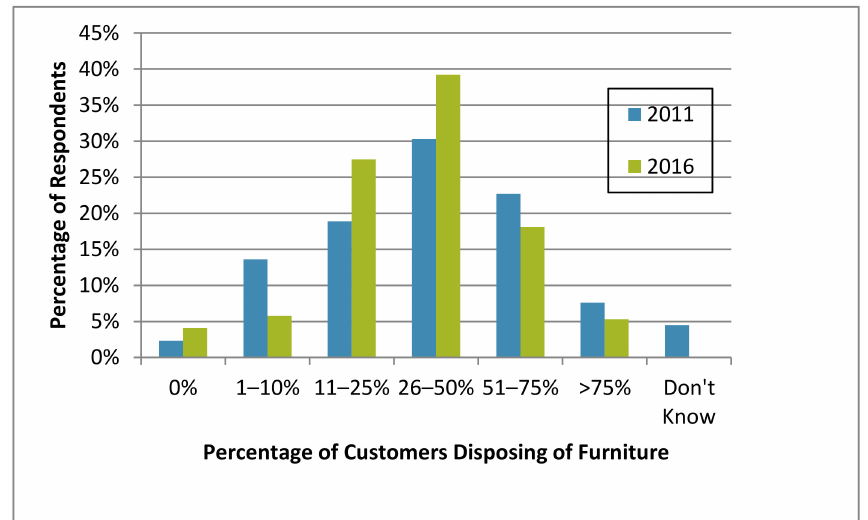
Figure 10. Estimated percentage of customers discarding infested furniture in in 2011 and